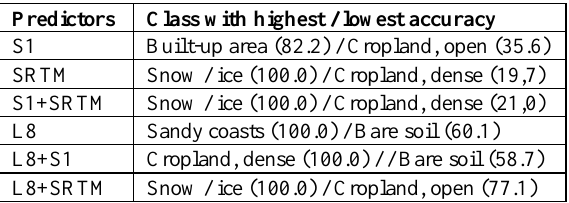
Table 5. User accuracies by input